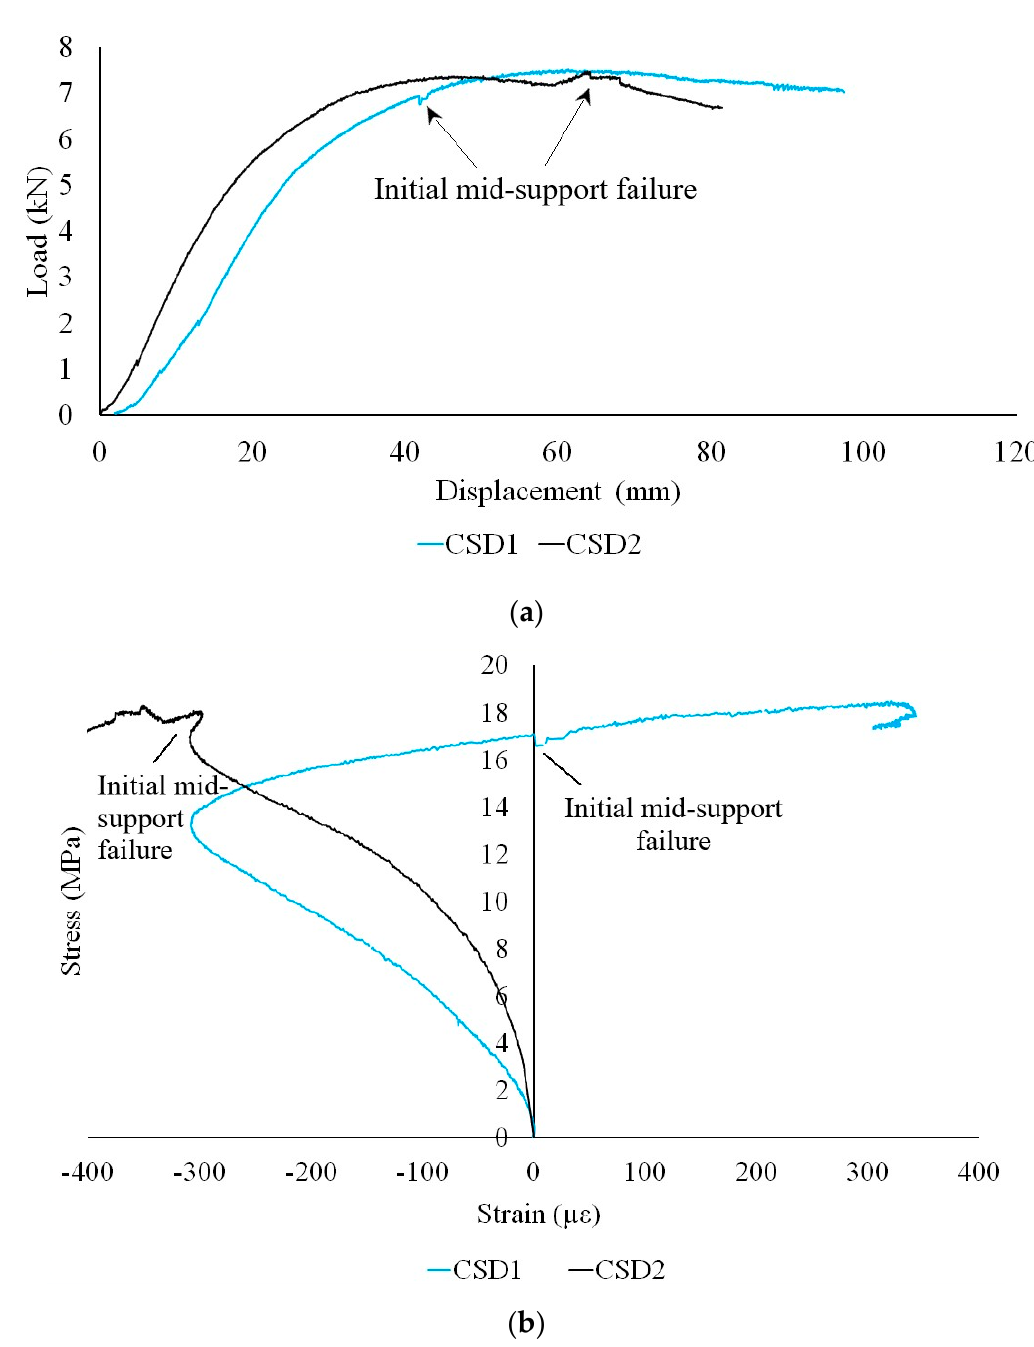
Figure 15. Results from continuous span deck tests: ( a ) load vs. deflection curve for CSD; and ( b ) stress vs. strain curves for CSD close to middle support.